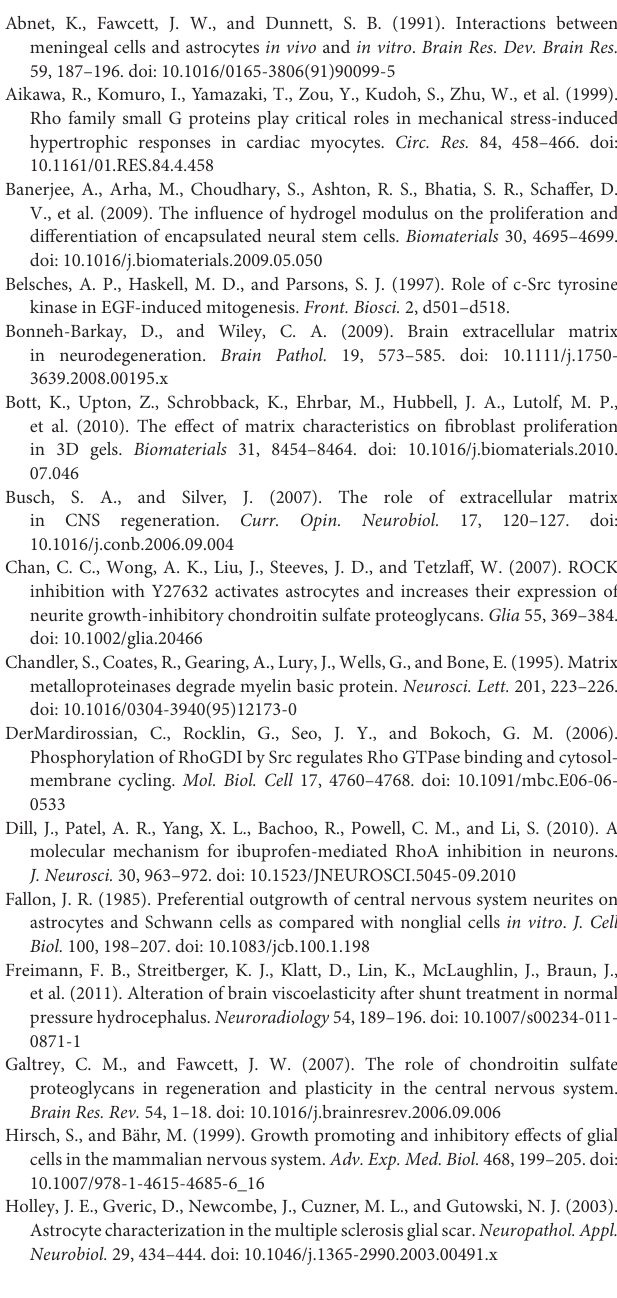
Image 3 | Physical properties of the alginate discs. (A) Calculated mesh size of the tested alginate formulations; (B) Rheological properties of alginate discs without